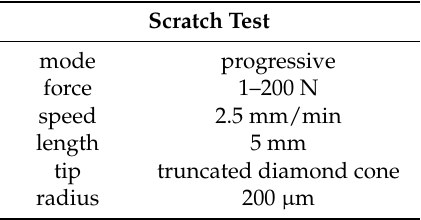
Table 2. Wear test